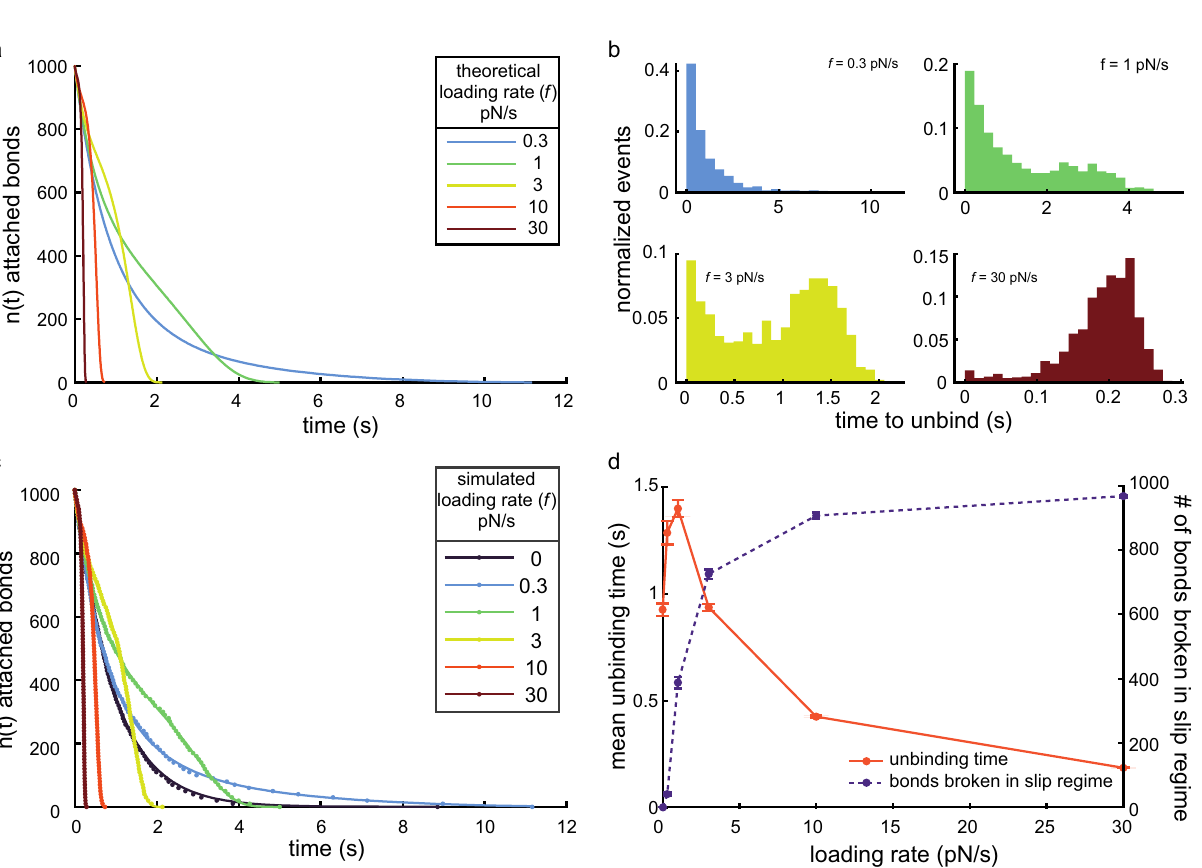
Figure 4. Calculating the force-dependent unbinding rate for catch-slip bonds. ( a ) Eq. (18a) plotted for various loading rates ( colored lines ) with N = 1000 slip bonds an unloaded unbinding rate of k 0,c = 1 s − 1 , catch bond force sensitivity of F c = 1 pN, slip bond unbinding rate of k 0,s = 0.05 s − 1 , and slip bond force sensitivity of F s = 1 pN, as in Fig. 2f. ( b ) Histograms of the time to unbind from a typical N = 1000 slip bond simulation with parameters as in ( a ) for various loading rates, as indicated. ( c ) Number of bound catch-slip bonds as a function of time for example simulations at various loading rates, as indicated. The data ( dots ) were fit to n ( t ) = Ne − k 0,c t for f = 0 ( dark purple line ) and Eq. (18a) for the others ( lines ). The equations were well-fit to the data in all of the example cases shown here, see Table S3 for the fit parameters and Supplementary Information for more detail. The same example simulation data were used as in panel ( b ), where applicable. ( d ) Mean unbinding time ( orange solid line , left axis) and mean number of bonds broken in the slip bond regime ( purple dashed line , right axis) of 50 simulations, with N = 1000 catch-slip bonds each, as a function of loading rate. The error bars represent the s.e.m. on both data